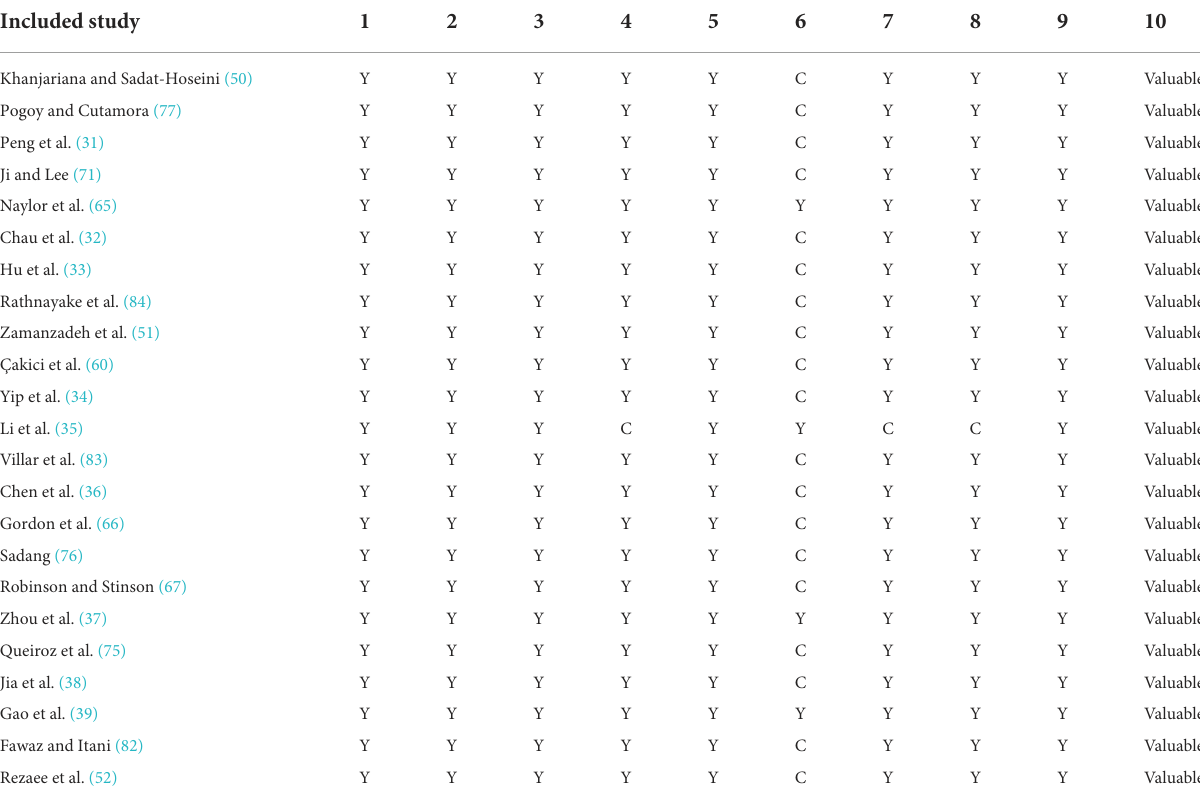
Category 3: Negative psychology peaked in the process of adapting to